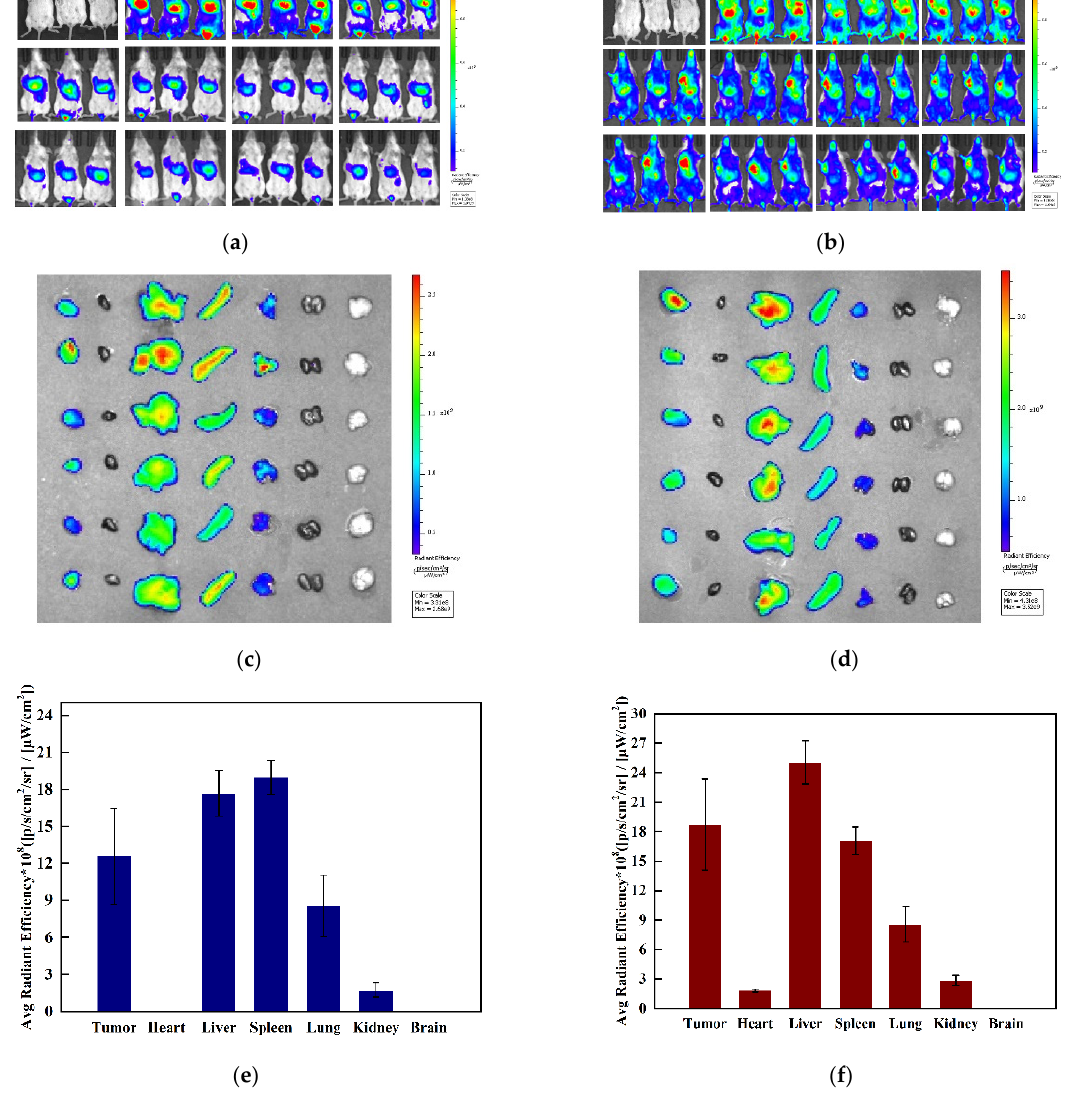
Figure 6. The in vivo biodistribution of DiR-labelled CP-liposome and Dir-labelled GMCP-liposome in 4T1 tumor-bearing mice. Dynamic in vivo bio-distribution of Dir-labelled CP-liposome ( a ) and DiR-labelled GMCP-liposome ( b ) at different time points (from left to right: 0 h, 0.5 h, 1 h, 2 h, 4h, 6 h, 8 h, 12 h, 24 h, 48 h, 72 h and 96 h post dose through tail vein. The fluorescent images of tumor and major organs of mice receiving DiR-labelled CP-liposomes ( c ) and DiR-labelled GMCP-lipo- somes ( d ) 16 h post dose (from left to right: tumor, heart, liver, spleen, lung, kidney, and brain) (n = 6, mean ± SD) and their Fluorescence semi-quantitative analysis ( e for CP-liposomes, f for GMCP- liposomes).